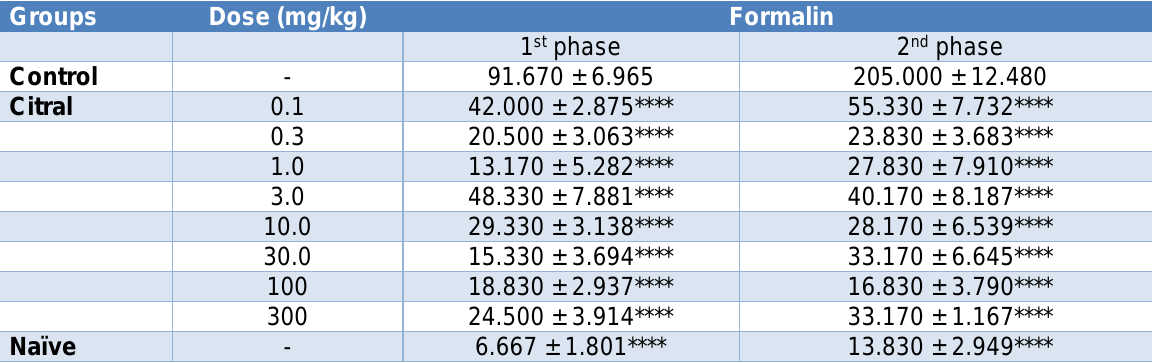
Table 1: Effect of citral on formalin 1st phase and 2nd phase nociception in mice Groups